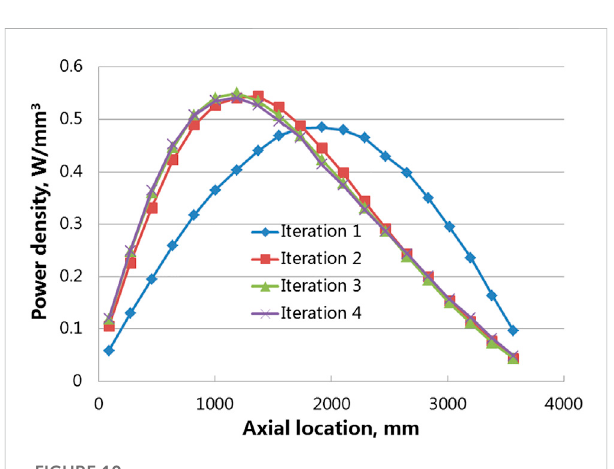
FIGURE 10 Power density along the center axis of the fuel rod during iterations.